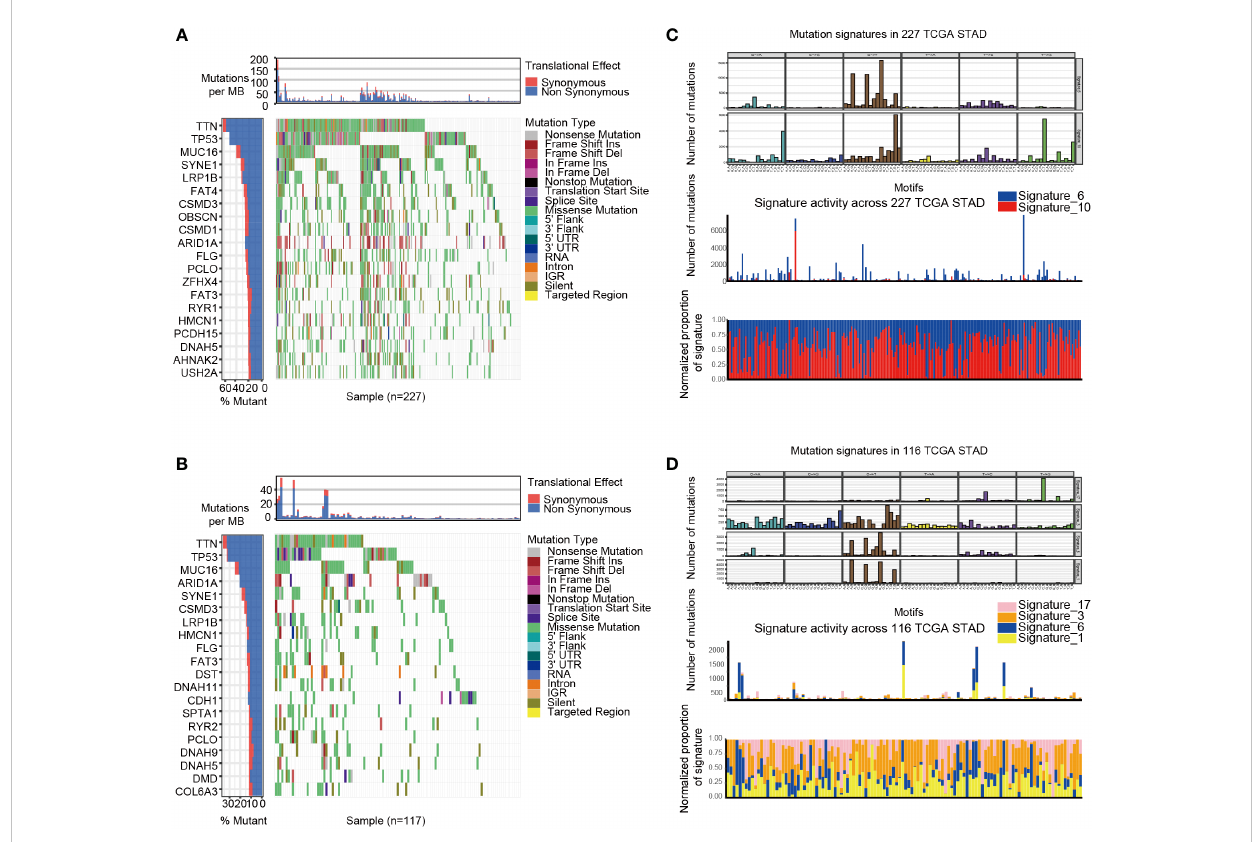
FIGURE 4 The mutation landscapes of cluster 1 and cluster 2. (A-B) The waterfall plot illustrates the single most damaging variant found per gene and per sample in TCGA, with colors indicating mutation types of cluster 1 (A) and cluster 2 (B) . (C) Mutation signature of cluster 1 is focused on signature 6 and 10. (D) Mutation signature of cluster 2 is focused on signature17, 3, 6 and